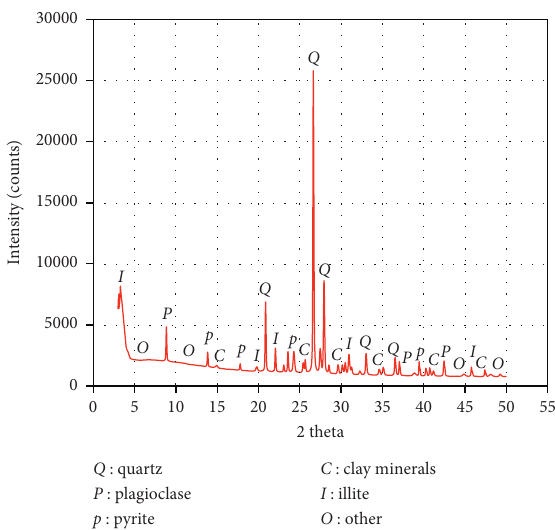
Figure 4: X-ray diffraction analysis of whole-rock